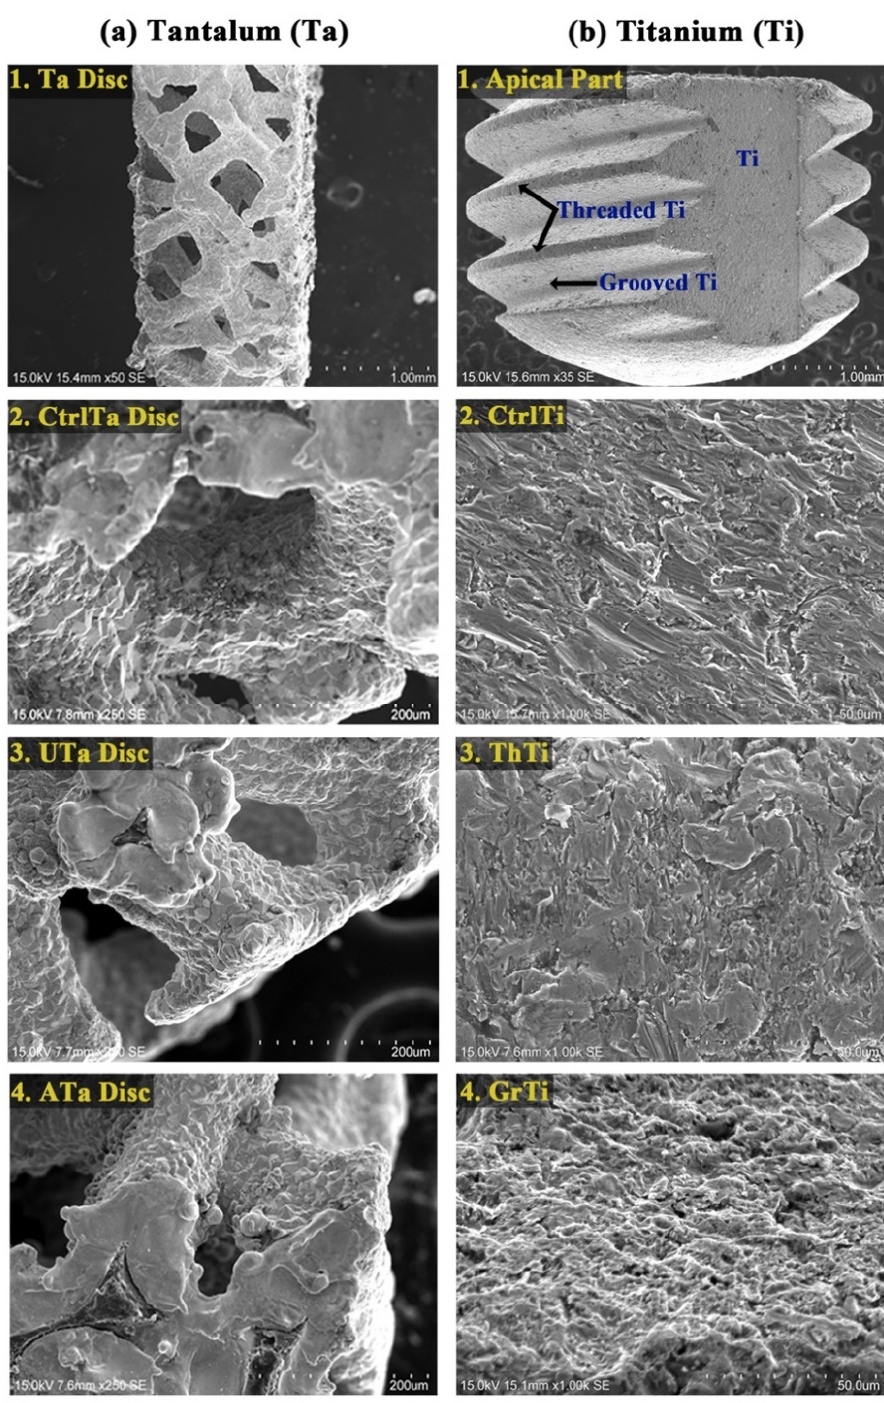
Figure 2. Scanning electron microscopic (SEM) analysis of PTTM implant. ( a ) Ta; 1. Ta discs (Scale bar = 1.00 mm), 2. CtrlTa Disc (Scale bar = 200 µm, 3. UTa Disc (Scale bar = 200 µm, 4. ATa Disc (Scale bar = 200 µm); ( b ) Ti; 1. Apical part of Ti with different surfaces (Scale bar = 1.00 mm), 2. CtrlTi (Scale bar = 50 µm), 3. ThTi (Scale bar = 50 µm), 4. GrTi (Scale bar = 50 µm).